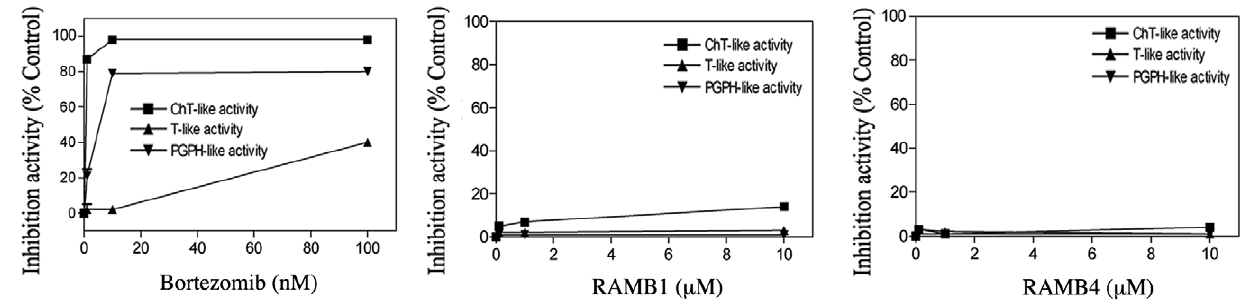
Figure 4. RAMB treatment fails to inhibit the 20S proteasome proteolytic activities. Purified 20S proteasomes were treated for 30 min with or without RAMB compounds or Bortezomib, here used as positive control, at the indicated concentrations and the specific fluorogenic substrates for chymotrypsin-like, trypsin-like and peptidylglutamyl peptide hydrolyzing-like hydrolytic proteasome capacities were subsequently added. A representative example of two independent experiments is shown.